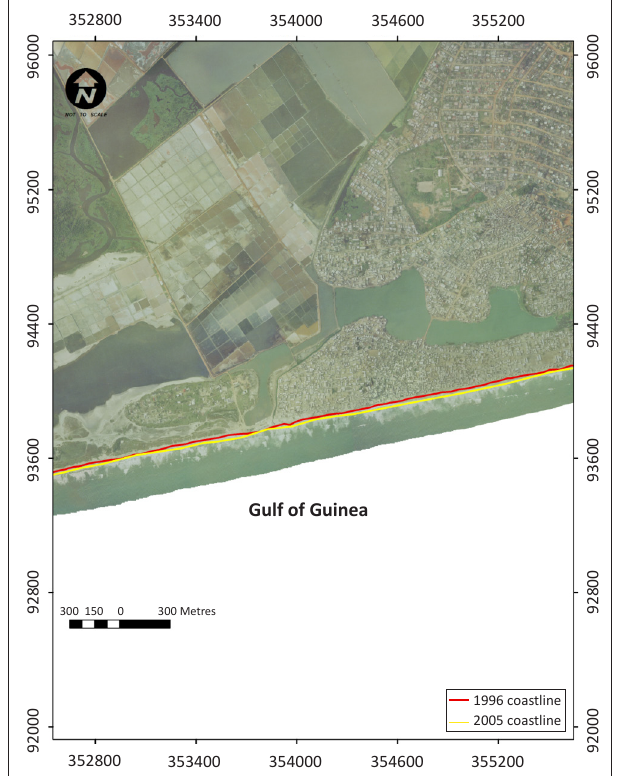
FIGURE 11: Overlay of the two shoreline positions to detect change.